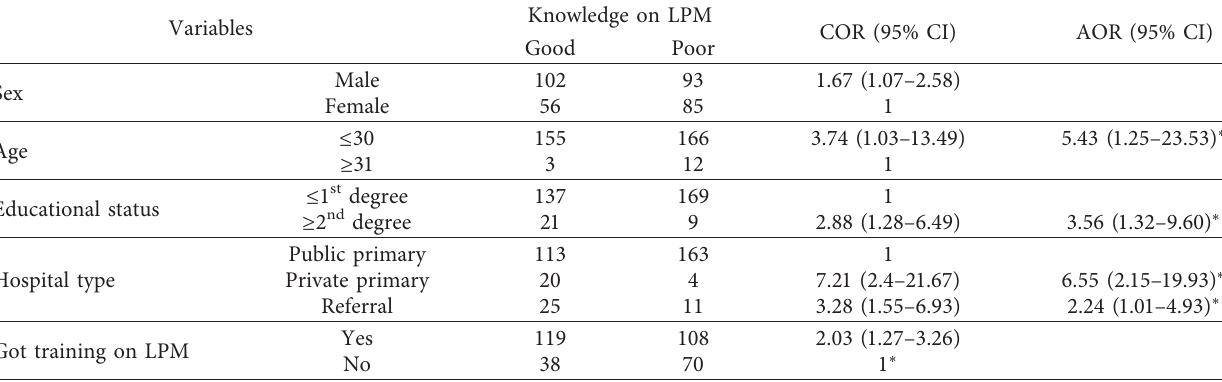
Table 3: Factors associated with knowledge on LPM among SBAs working at hospitals in Gondar zones, northwest Ethiopia,